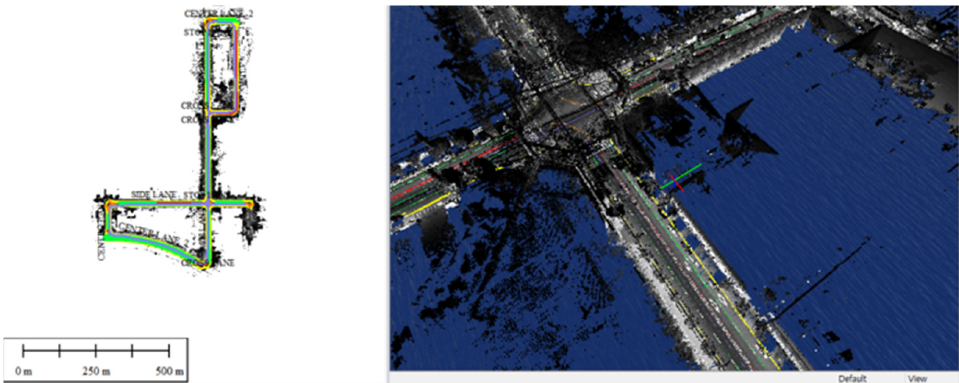
Figure 10. Dynamic high-definition map-drawing process.